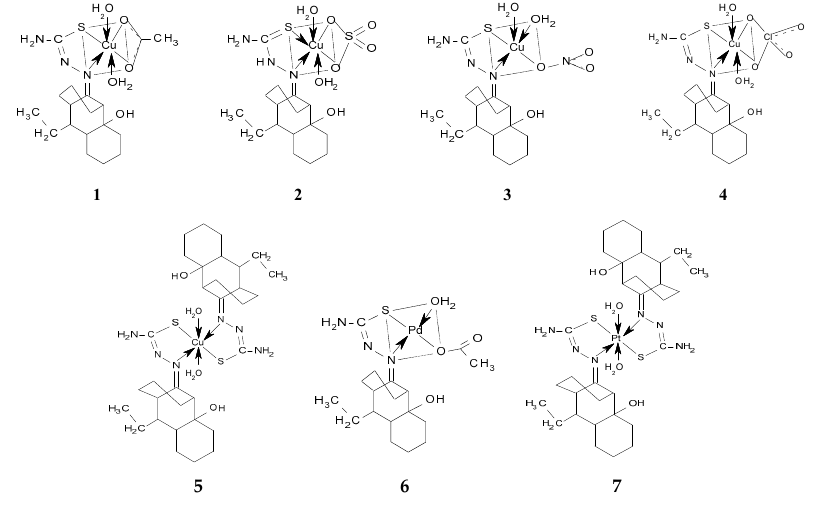
Figure 1. Proposed structures of the newly obtained metal complexes 1 – 7 .